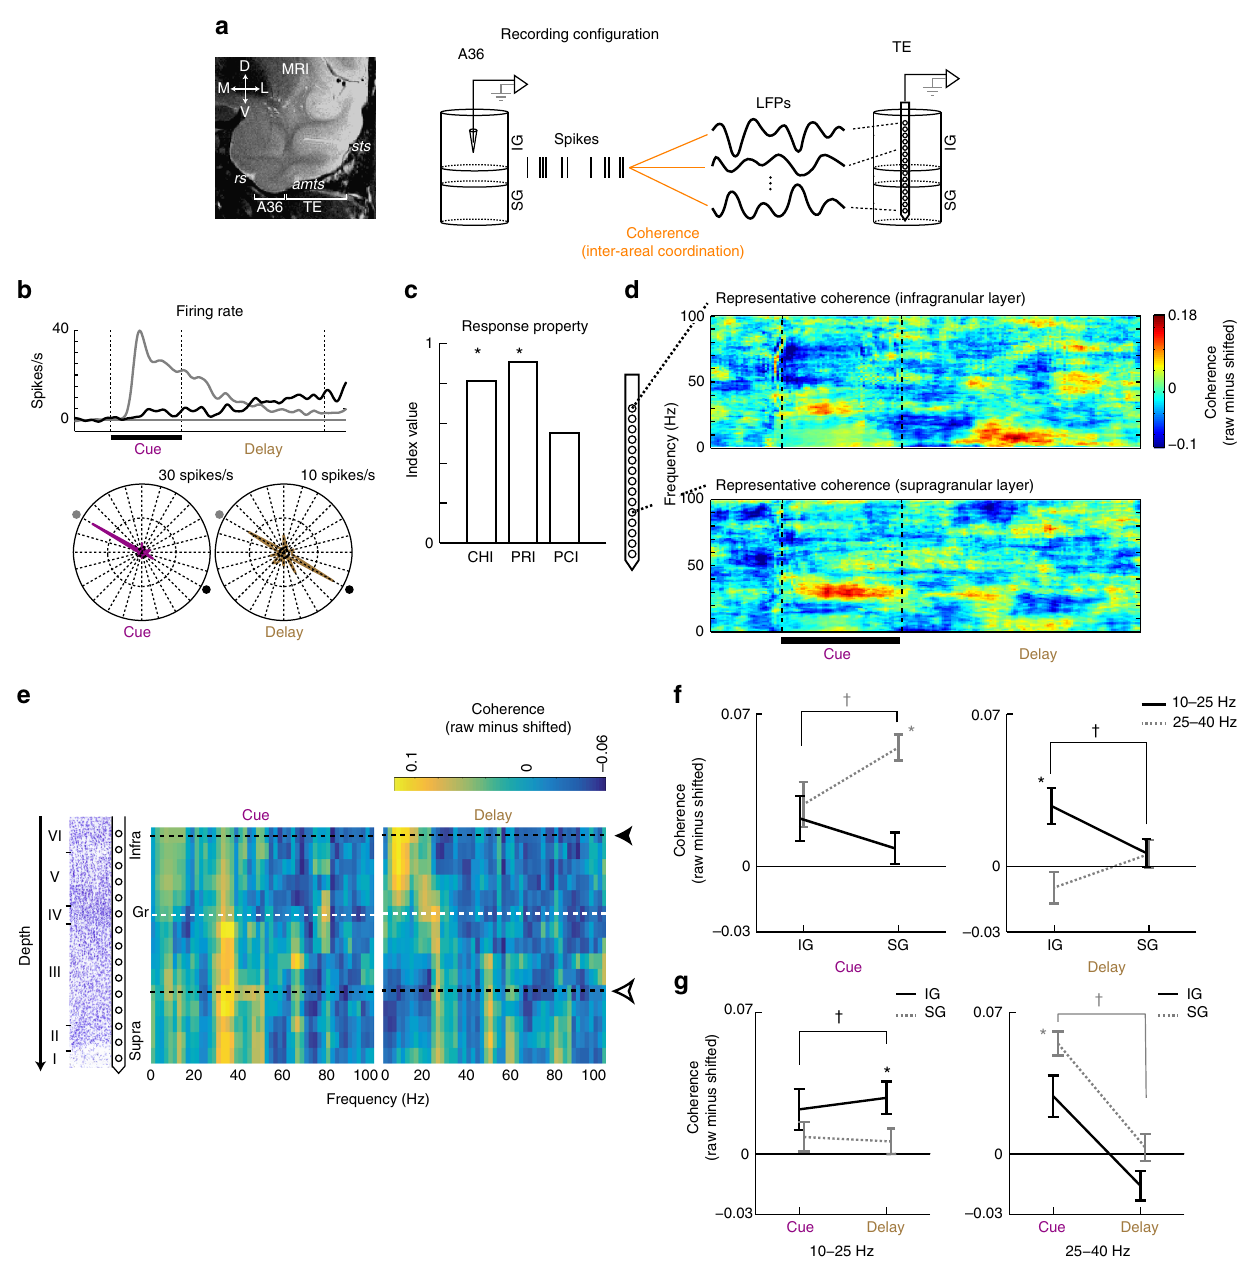
Fig. 2 Recording con fi guration and representative data showing dynamic transition in layer speci fi city of the inter-areal signal. a Spiking activities were recorded from A36, while local fi eld potentials (LFPs) were recorded from TE by using a multi-contact linear array electrode. Inter-areal interaction was examined by coherence between these two signals. Cortical depths of the recording sites in A36 and TE were determined by histology and current source density of the LFP (see also Supplementary Fig. 13). IG infragranular layer, SG supragranular layer. b – f Representative data. b Top, spike density functions for the trials in which the presented cue stimulus exerted the largest response during the cue period (gray) and its paired associate was presented as a cue stimulus (black). We analyzed the latter trial (shown in black) for inter-areal coherence. Bottom, polar plots of mean fi ring rates during the cue and delay periods, shown for each cue stimulus. The responses to a stimulus and its paired-associate are indicated by radial lines. c Stimulus coding indices. CHI cue- holding index, PRI pair-recall index, PCI pair-coding index. *, P < 0.05. d Dynamics of coherence (coherogram) between A36 spikes and TE LFPs at the infragranular layer (top) and at the supragranular layer (bottom). The subtraction of trial-shifted control from raw coherence is shown. e Layer speci fi city of coherence as a function of frequency. The amplitude of coherence is color-coded. Black and white arrowheads depict coherograms shown in d . Left, corresponding histological section. f Laminar dynamics of coherence at 10 − 25 (black solid line) and 25 − 40 (gray dotted line) Hz during the cue (left) and delay (right) periods. g Temporal dynamics of coherence in IG and SG Hz at 10 − 25 to 25 − 40 Hz. P < 0.0001 for interaction between layer and frequency, between period and layer, and between period and frequency; F = 0.15, P = 0.69 for interaction among three effects, by three-way ANOVA for the effects of period, layer and frequency. *, P < 0.05; t -test against zero, corrected for multiple comparisons. † , P < 0.05; paired t -test, corrected for multiple comparisons. Error bars, mean ±